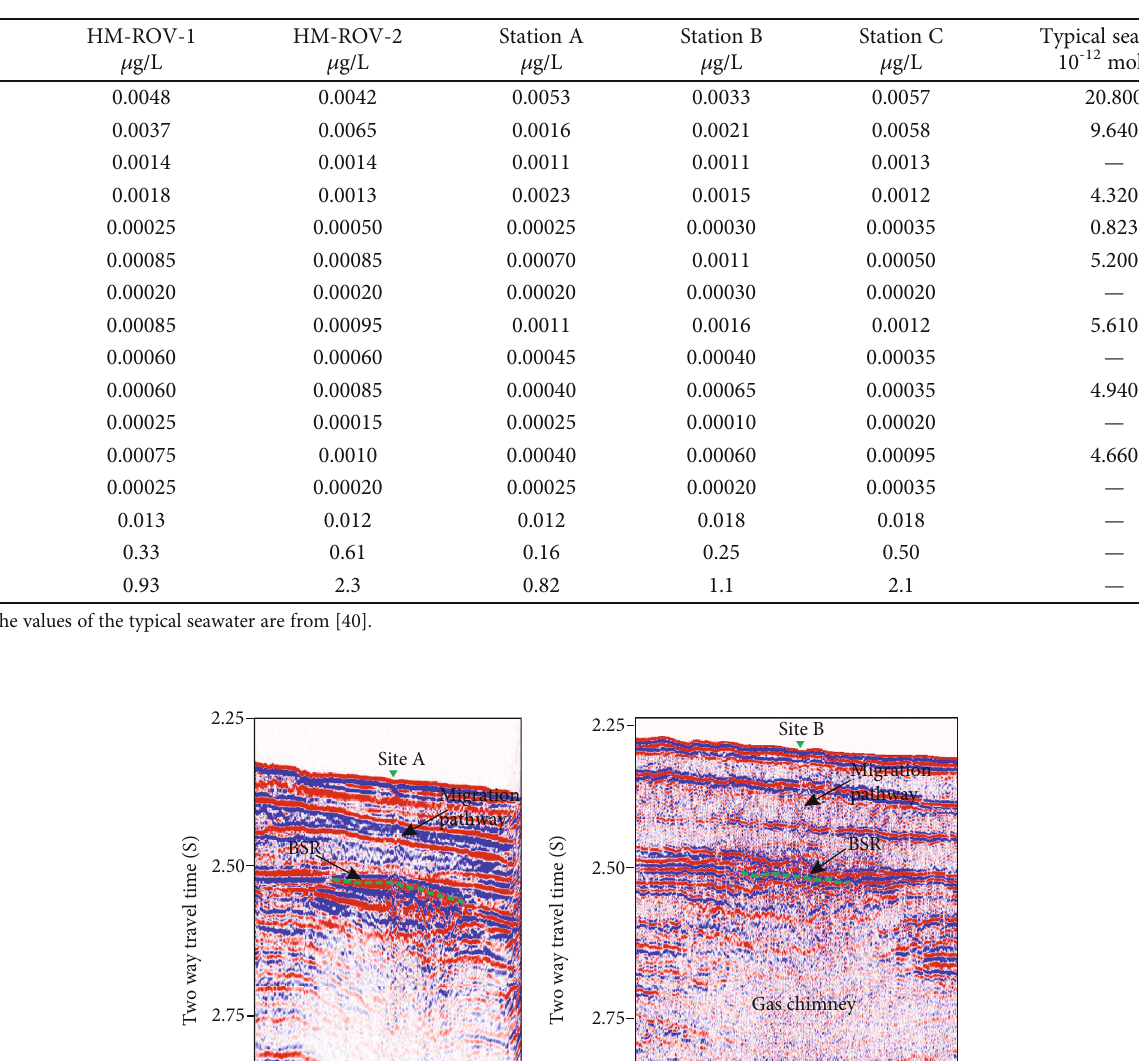
Table 5: Concentrations of REEs and values of δ Ce and δ Eu .